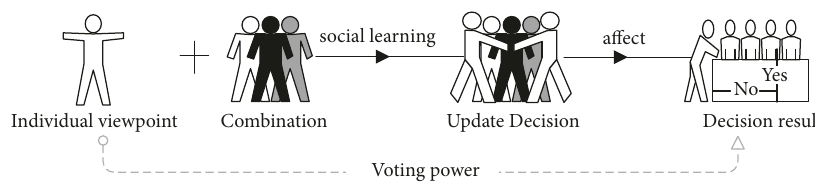
Figure 3: The influence of social learning on the voting